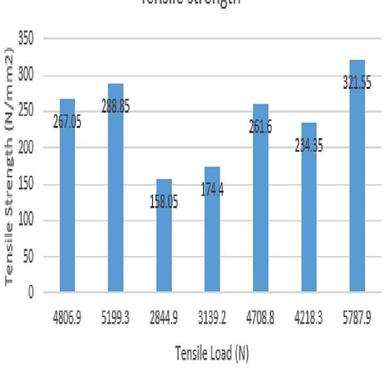
Tensile Strength of the C–C Laminate under various loads.